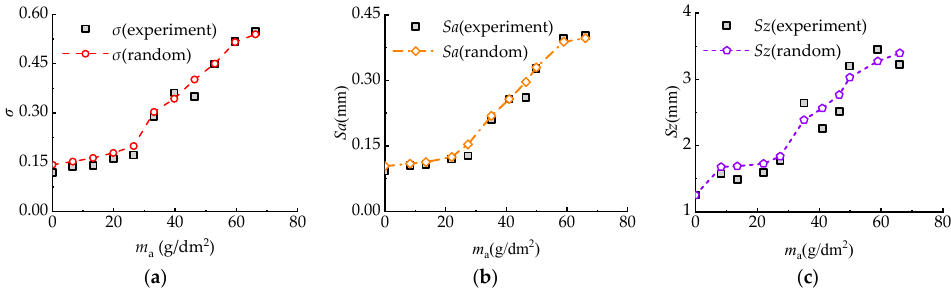
Figure 15. Comparison diagrams: ( a ) standard deviation σ ; ( b ) arithmetic mean height S a; ( c ) maxi- mum height S z.